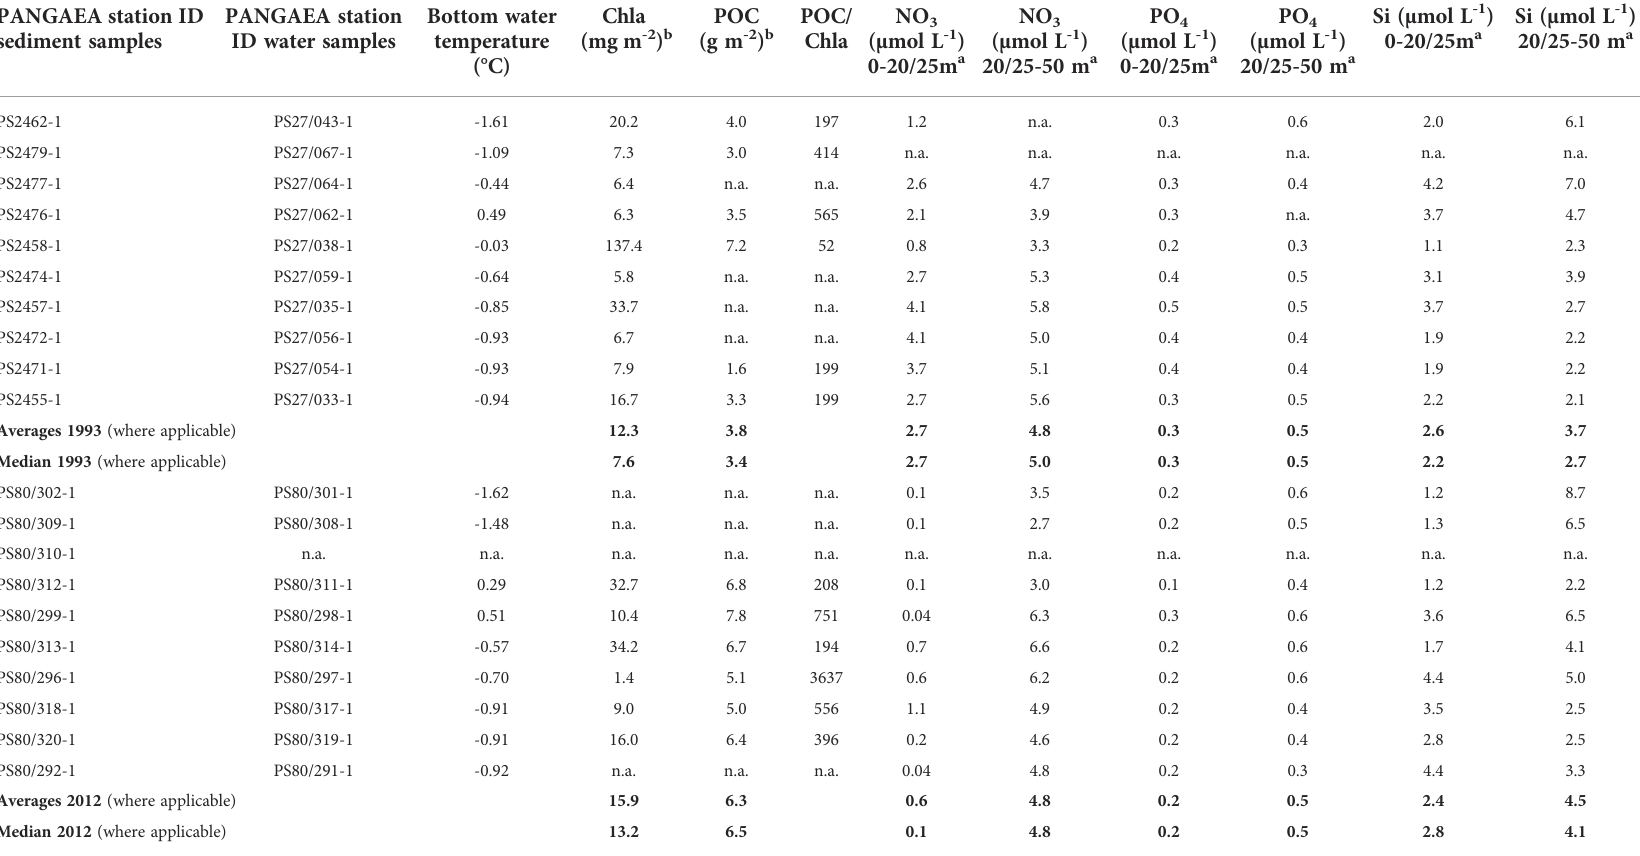
TABLE 4 Variables derived from water column samples collected from pelagic (CTD/Rosette) stations corresponding to main benthic (MUC) stations sampled in 1993 and 2012. PANGAEA station ID sediment